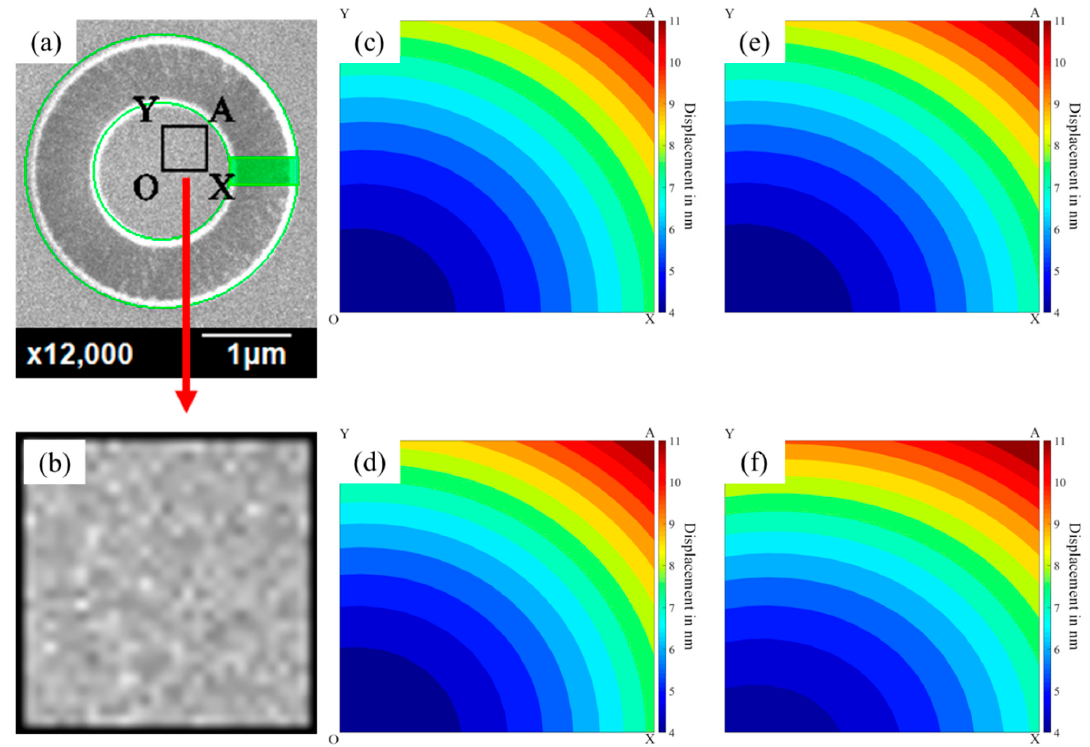
Figure 5. The deformation image of FIB-DIC was analyzed through the displacement distribution of the field on the ZrN thin film at a magnification of 12,000 × by DIC performed in Figure 4. As a result of the symmetrical deformation pattern of the ring core, these results only present the first quarter of the ring with the rectangular area of point O, X, A & Y. As illustrated: ( a ) the whole SEM image of the sample surface taking after milling; ( b ) Zooming SEM image with the rectangular area of point O, X, A & Y; ( c ) Displacement field of the rectangular area of point O, X, A & Y after the first milling depth, 0.6 µ m; ( d ) Displacement field of the rectangular area of point O, X, A & Y after the second milling depth, 0.8 µ m; ( e ) Displacement field of the rectangular area of point O, X, A & Y after the third milling depth, 1.0 µ m; ( f ) Displacement field of the rectangular area of point O, X, A & Y after the fourth milling depth, 1.1 µ